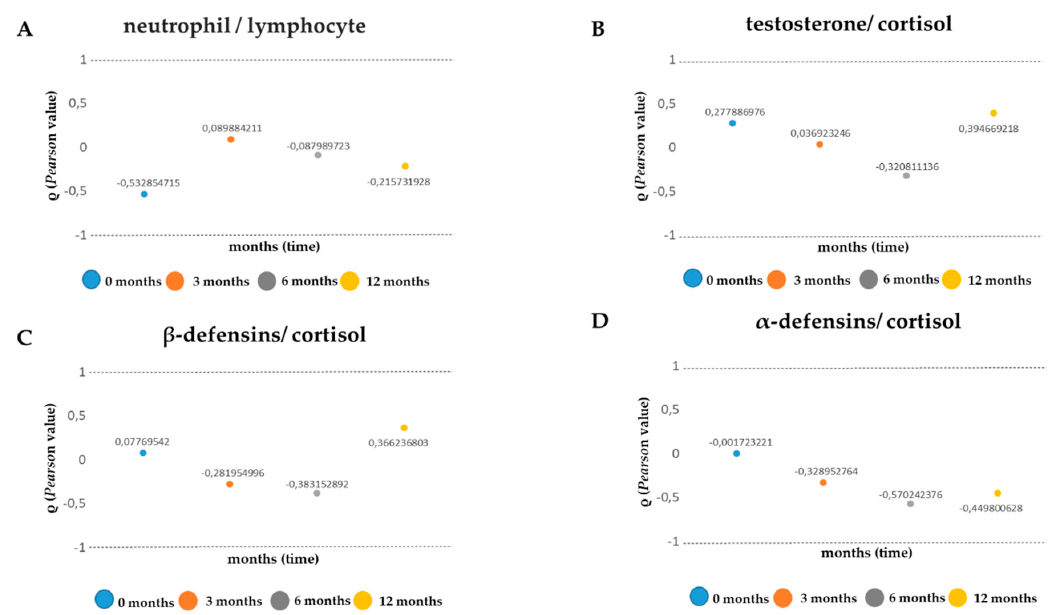
Figure 4. Inflammatory indices. ( A ) testosterone / cortisol ratios; ( B ) neutrophil / lymphocyte ratios; ( C ) beta-defensin / cortisol ratios; ( D ) alpha-defensin / cortisol ratios. Values obtained from the Pearson’s analysis are reported on the y-axis; time is reported on the x-axis.